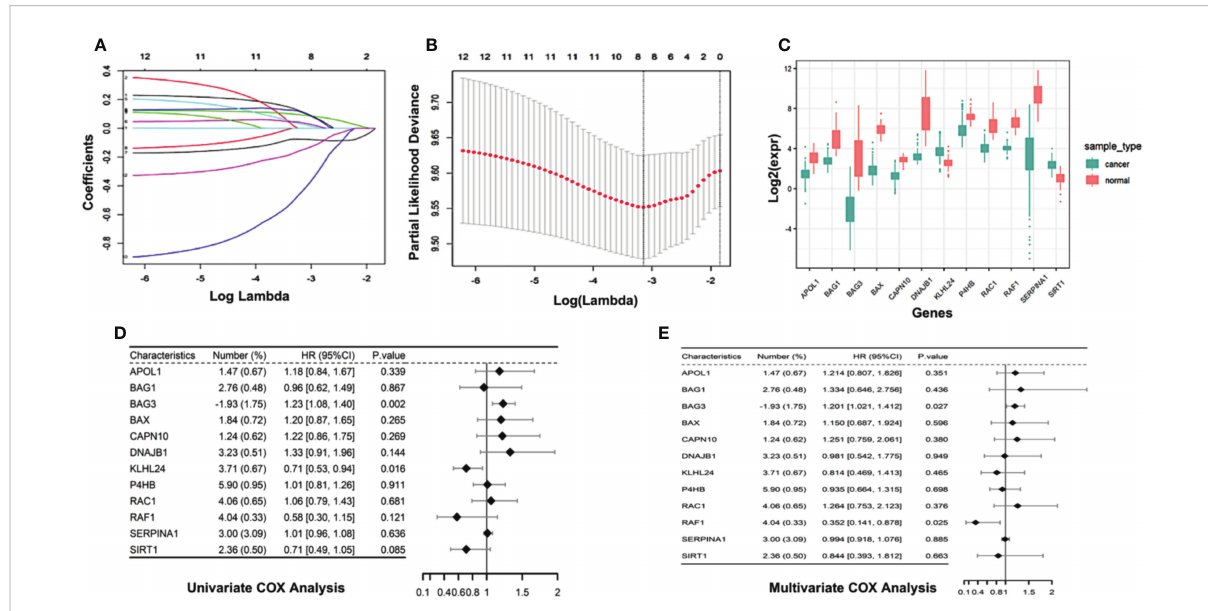
FIGURE 2 Construction of autophagy-associated prognostic model in TCGA-AML cohort. (A) 10-fold cross-validation of tuning parameter selection in LASSO model using the TCGA- AML data. (B) LASSO coef fi cient of the selected 12 autophagy-associated genes. (C) Boxplot comparing the difference in gene expression of the selected 12 autophagy-associated genes between AML patients and normal controls. (D, E) Univariate Cox analysis (D) and multivariate Cox analysis (E) show the coef fi cients and corresponding p values of individual genes within 12 autophagy- associated